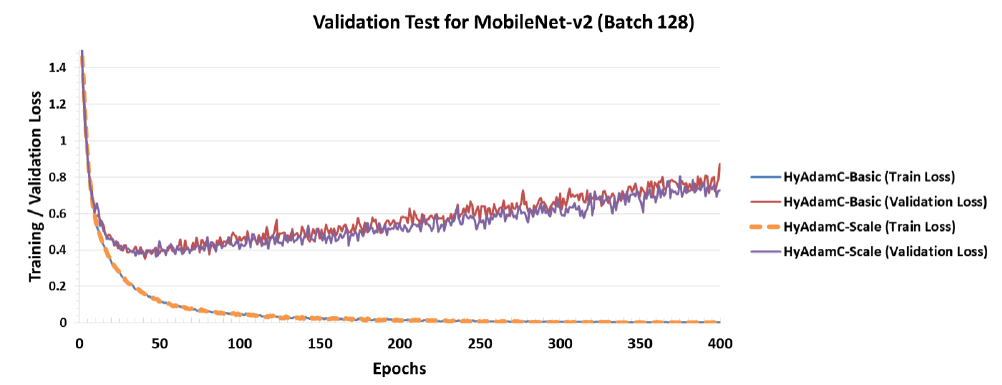
Figure 29. The training and validation loss curves of HyAdamC-Basic and HyAdamC-Scale in